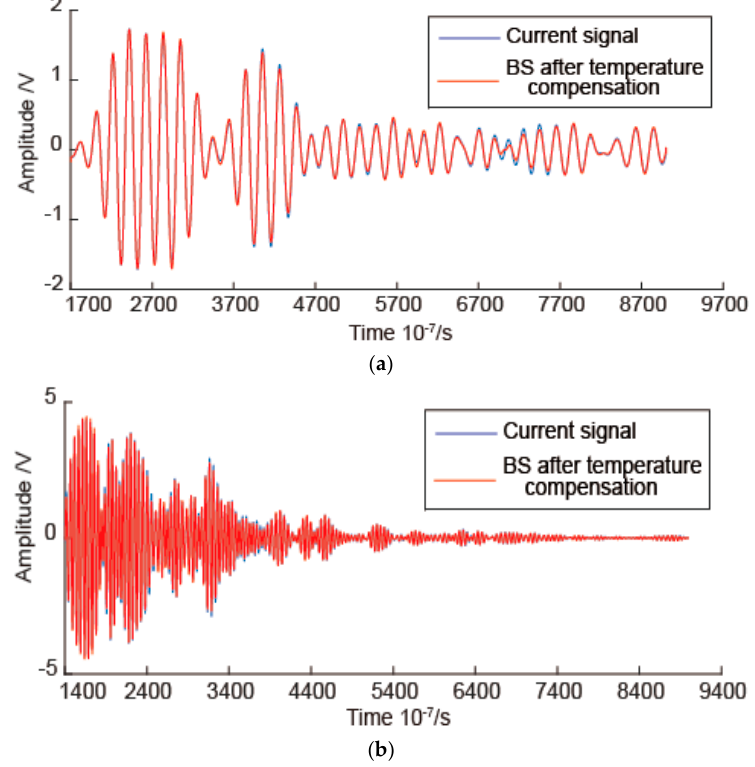
Figure 7. The comparison of 53 °C current signal and the temperature compensation signal of 44 °C baseline signal at two frequencies: ( a ) Signal with frequency 50 kHz; ( b ) Signal with frequency 190 kHz.